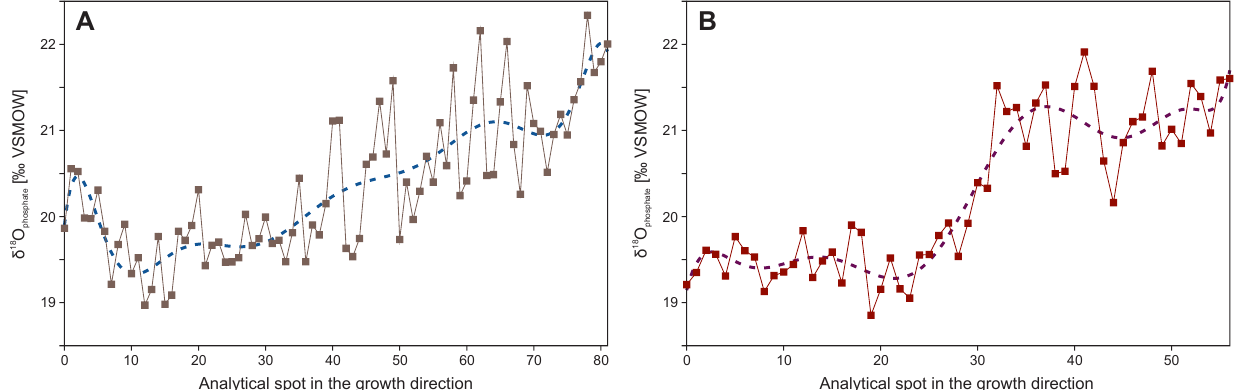
Figure 14. Ontogenetic δ 18 O trends throughout the enamel layer of two teeth (samples ( A ) and ( B )) of mid-Tithonian (Upper Jurassic) ichthyosaur ( Cryopterygius kielanae ) from central Poland. Early portion of the enamel is characterized by low δ 18 O values (~19.4% VSMOW), and ontogenetic increases to ~21.9% and ~21.4% VSMOW in samples A and B, respectively, are observed. Average δ 18 O trends are shown (reproduced with permission from Wierzbowski et al. [41]. “Oxygen isotope profiles of uppermost Jurassic vertebrate teeth and oyster shells: a record of paleoenvironmental changes and animal habitats”. Palaios, 2019, v. 34, p. 585–599. Copyright SEPM